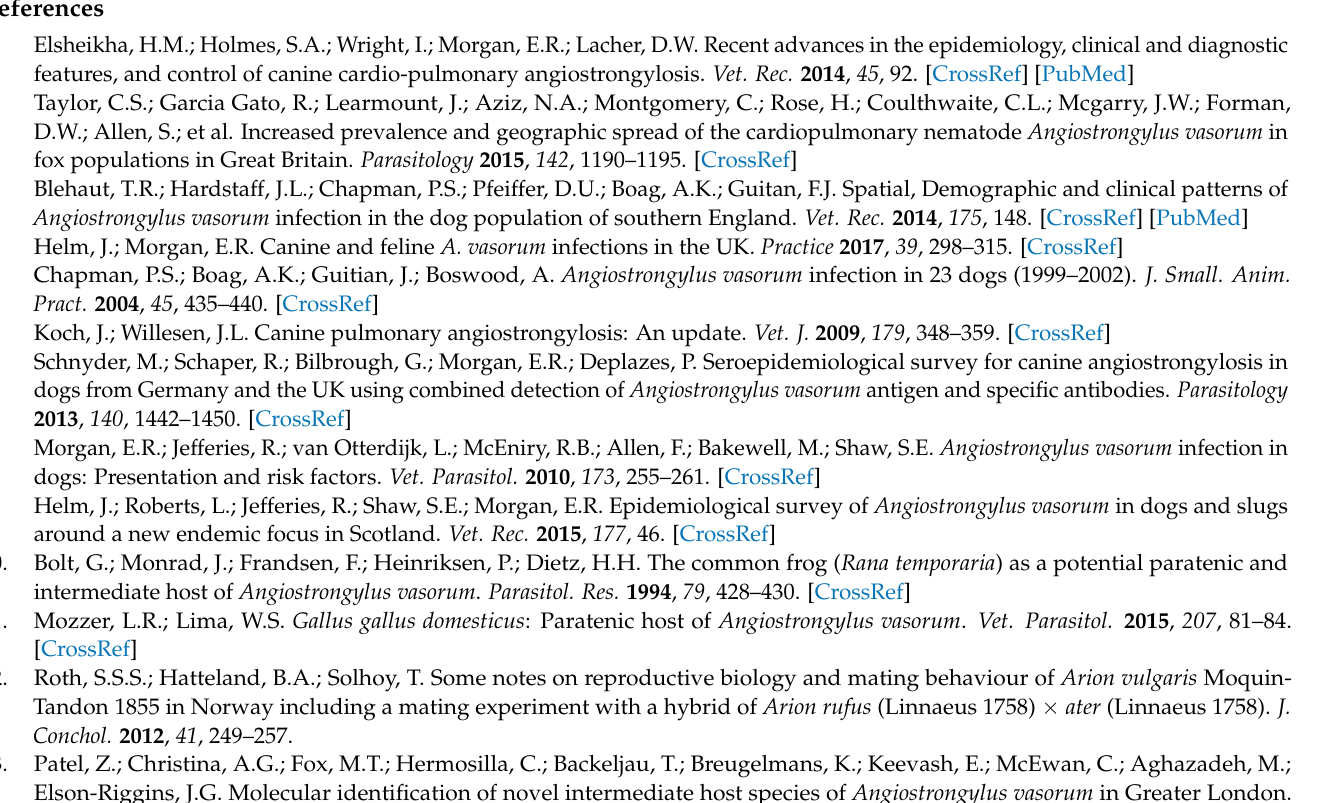
areas. Table S2: Parameter estimates and pairwise comparisons for factors predicting gastropod relative abundance across 7 study sites in Brighton and Hove and surrounding areas. · approaches significance. Table S3: Parameter estimates and pairwise comparisons for factors predicting pres- ence/absence of Arion ater and hortensis aggregates, and Cornu aspersum (taxa harbouring medium and high prevalence of Angiostrongylus vasorum from the literature) across 7 study sites in Brighton and Hove and surrounding areas. Table S4: Parameter estimates and pairwise comparisons for signif- icant effects predicting dog presence/absence (0,1) across 7 study sites in Brighton and Hove and surrounding areas. AM = 06.30–10.30; MID (midday) = 12.30–16.30; PM = 18.30–22.30. · approaches significance. Table S5: Parameter estimates and pairwise comparisons for significant effects predicting dog (Canis lupus familiaris) abundance across 7 study sites in Brighton and Hove and surrounding areas. AM = 06.30–10.30; MID (midday) = 12.30–16.30; PM = 18.30–22.30. · approaches